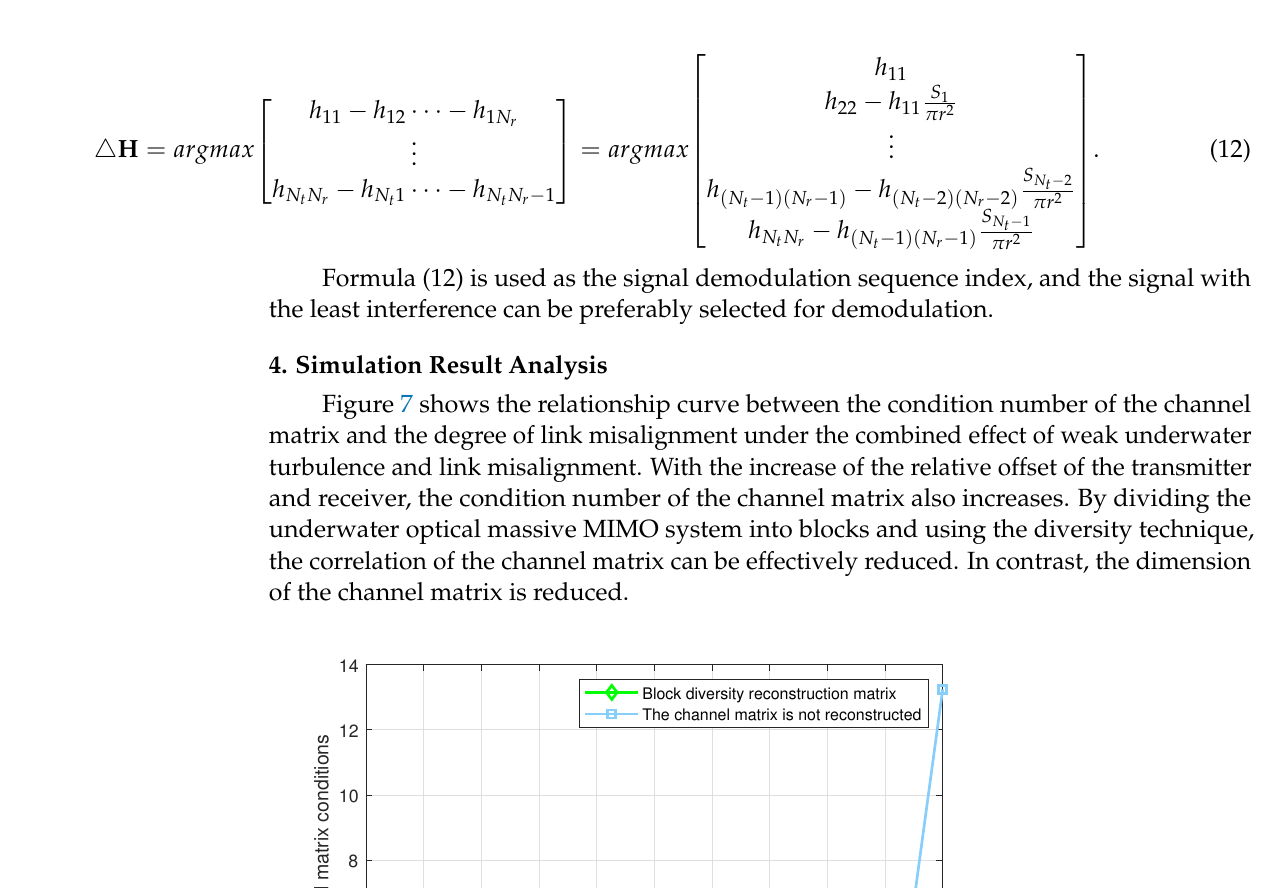
reduced, and the correlation between sub-channels is further